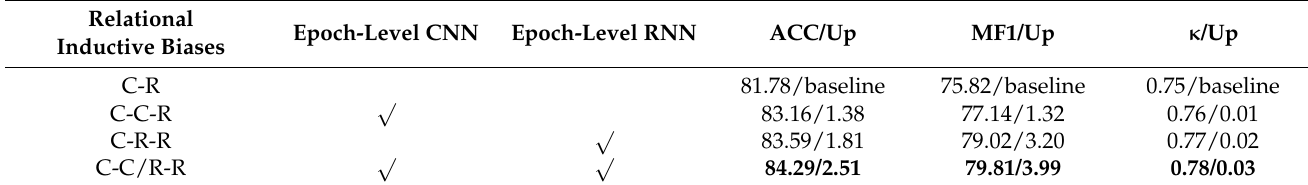
Table 5. The impact of relational inductive biases on network performance.